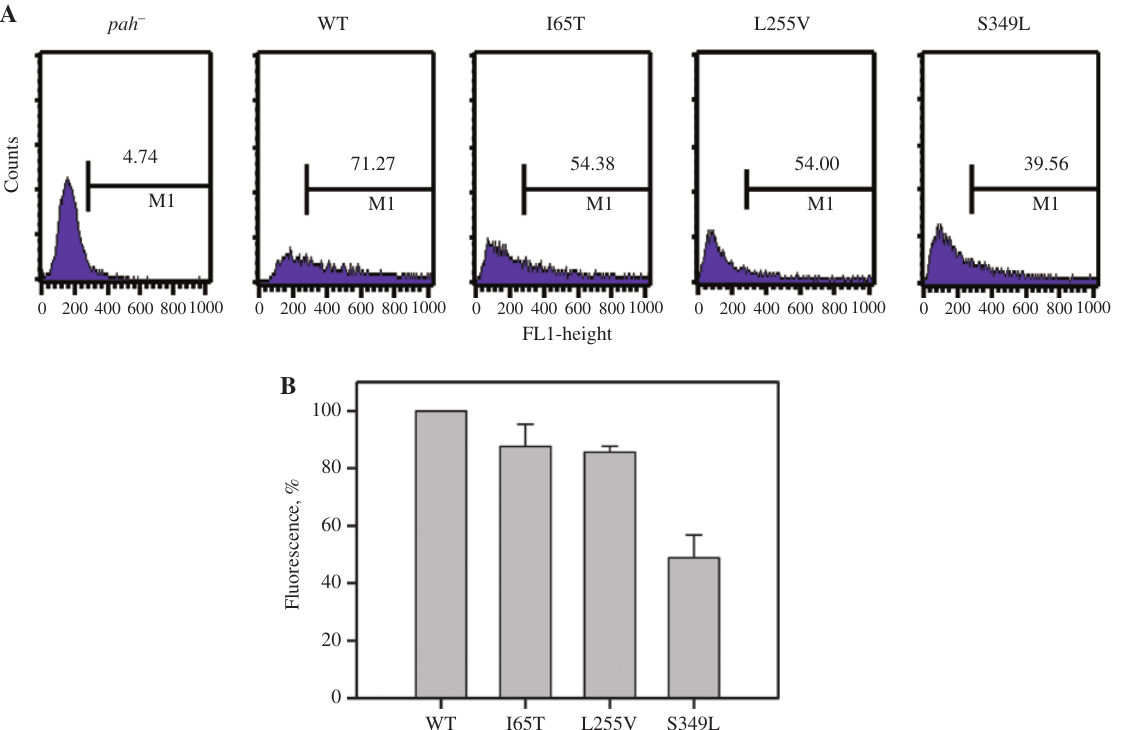
Figure 1: FACS analysis of pah − cells expressing GFP-hPAHs. (A) Representative FACS histograms. The peak pattern represents fluorescent profile of the cells. The gated region (M1) for positive GFP cells is indicated by the bar. The number reflects positive cell percentage. (B) The positive cell percentages relative to WT values were plotted as mean ± SD of the data from three independent experiments.